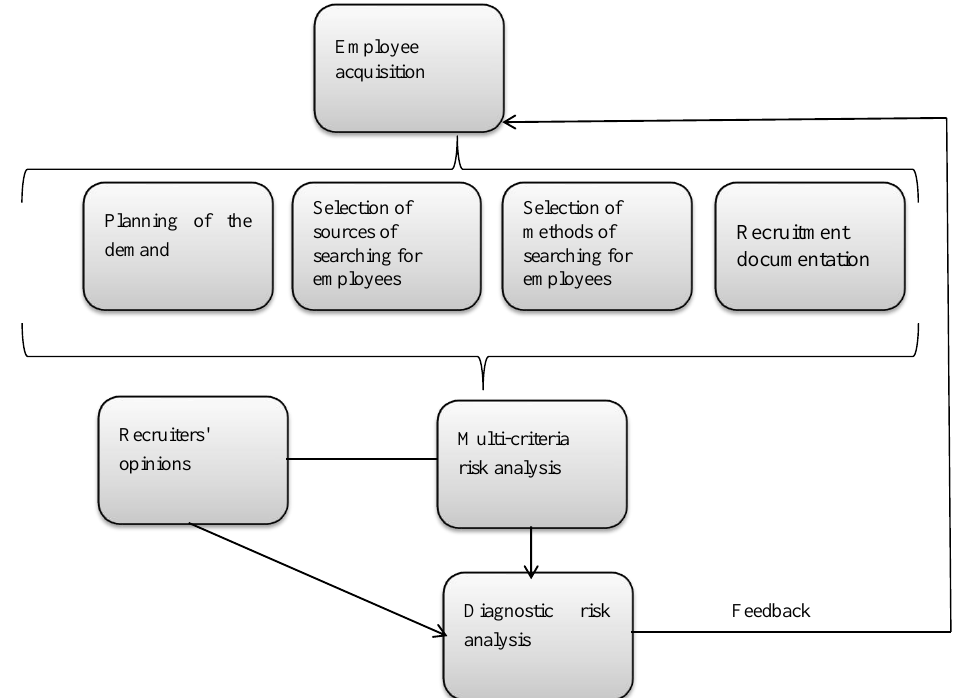
Chart 1. Dependencies in the developed model. Source: own